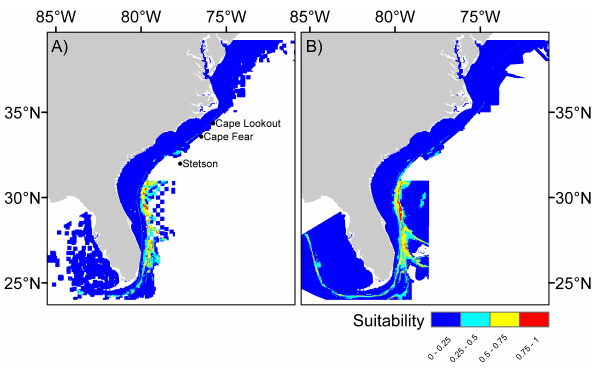
Fig. 2. Habitat suitability models for L. pertusa in the southeastern US shelf: (A) a model created using sediment type and (B) a model without sediment incorporated. The larger area of the non-sediment layer is a result of the limited sediment data available for the region. Higher suitability values indicate that the area is more suitable for coral occurrence but do not mean that corals will be found there as there may be other variables constraining occurrence that are not used in the